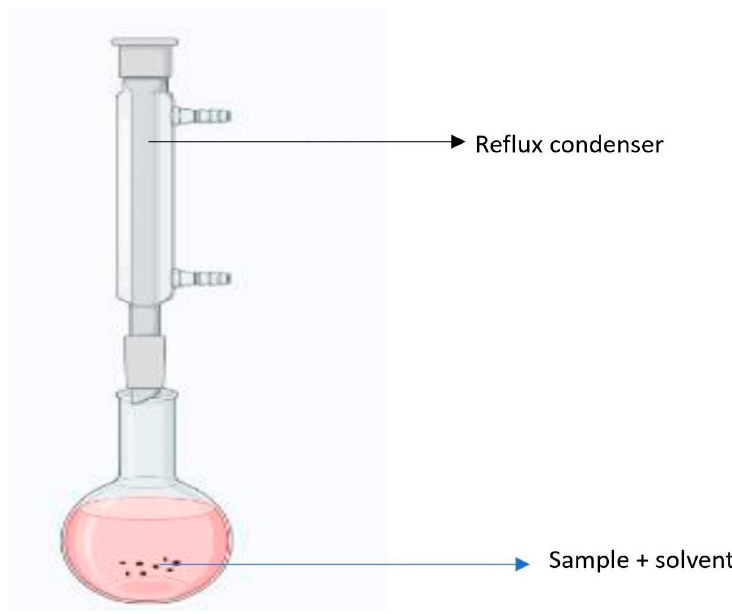
Figure 4. A diagrammatic representation of reflux extraction.